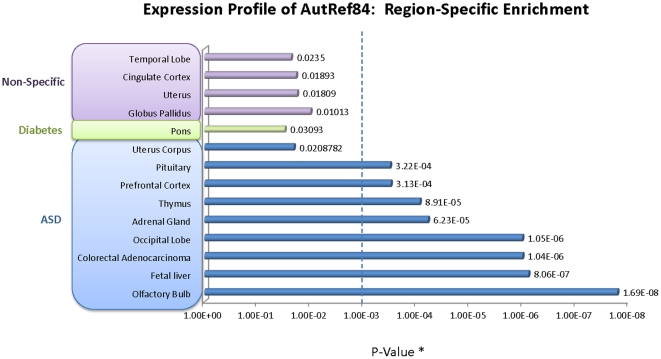
AutRef84 expression profile: region-specific enrichment of gene expression.Analysis of tissue expression profiles for AutRef84 genes using the DAVID bioinformatics tool (http://david.abcc.ncifcrf.gov/) demonstrates region-specific enrichment with high statistical significance (p<0.0001) in four areas of the central nervous system: olfactory bulb, occipital lobe, prefrontal cortex, and pituitary. Whereas the olfactory bulb and occipital lobe are involved in sensory processing (smell and vision, respectively), the prefrontal cortex controls executive function and the pituitary gland directs hormone secretion. None of the enriched regions overlapped with those of diabetes or non-specific disease gene sets. * = Bonferroni corrected.